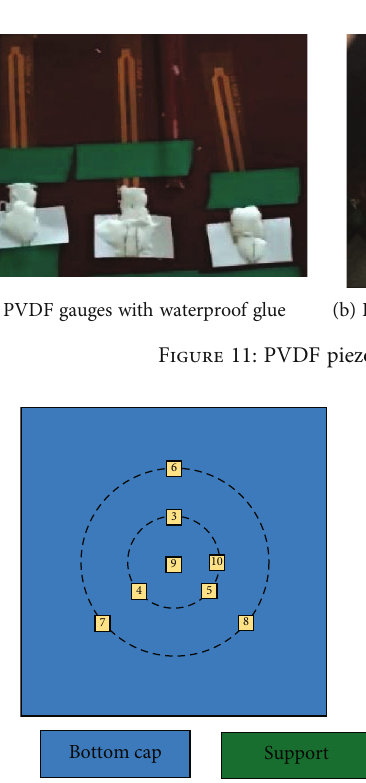
Figure 12: Positions of PVDF piezoelectric gauges.